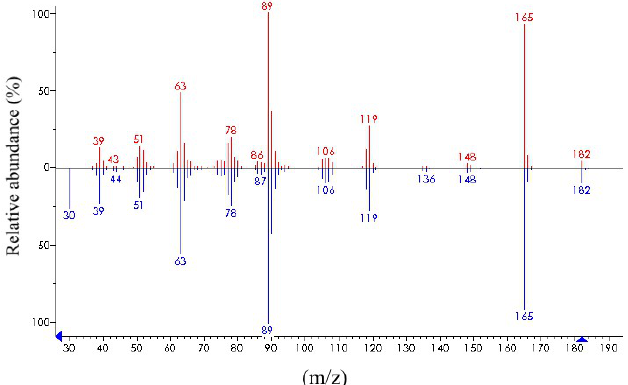
Figure A3. Modifications of the UV-cuvette lid to monitor oxygen and temperature and introduce molecular oxygen simultaneously ( a ). Exemplary picture of the lid mounted on a UV-cuvette ready for measurements ( b ).